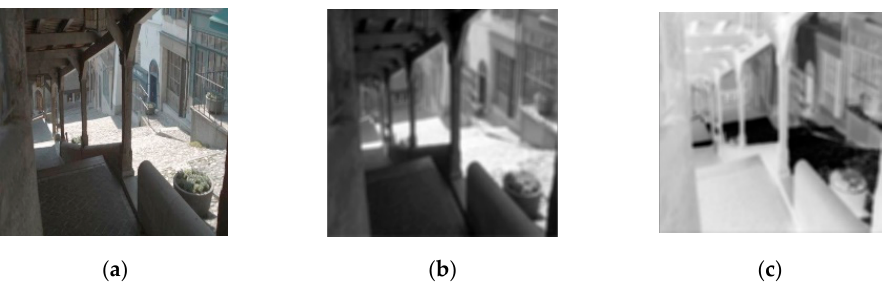
Figure 4. Example of the target luminance weighted map: ( a ) original image, ( b ) weighted map, and ( c ) inverse weighted map.